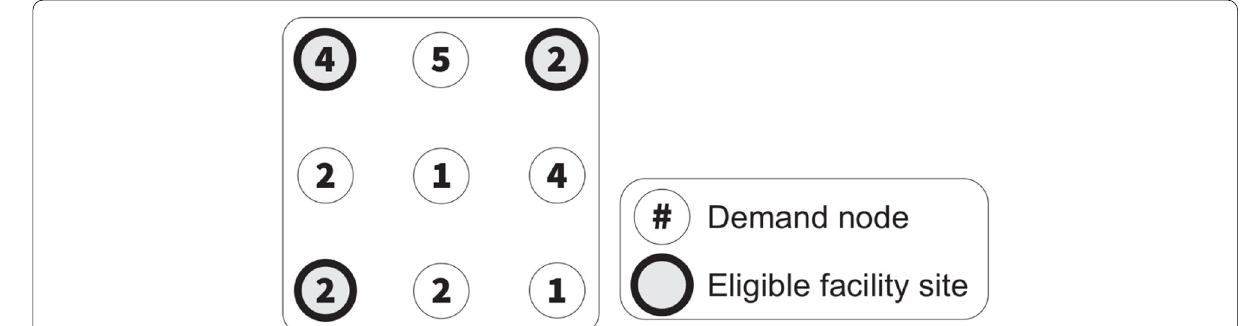
Fig. 2 Example of an MCLP